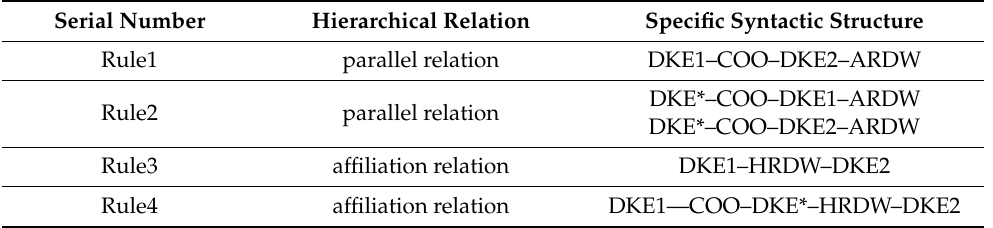
Table 3. The hierarchical relation extraction